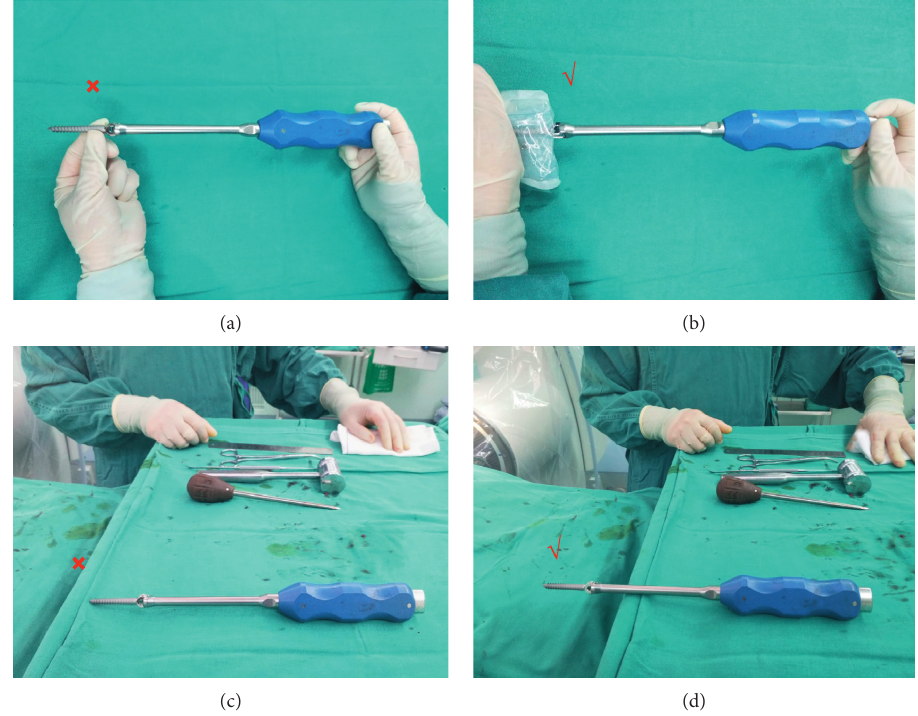
Figure 2: (a) Wrong: Dynesys screw was installed with direct touching; (b) correct: Dynesys screw was installed without direct touching. (c) Wrong: Dynesys screw was placed touching the cloth; (d) correct: Dynesys screw was placed without touching the